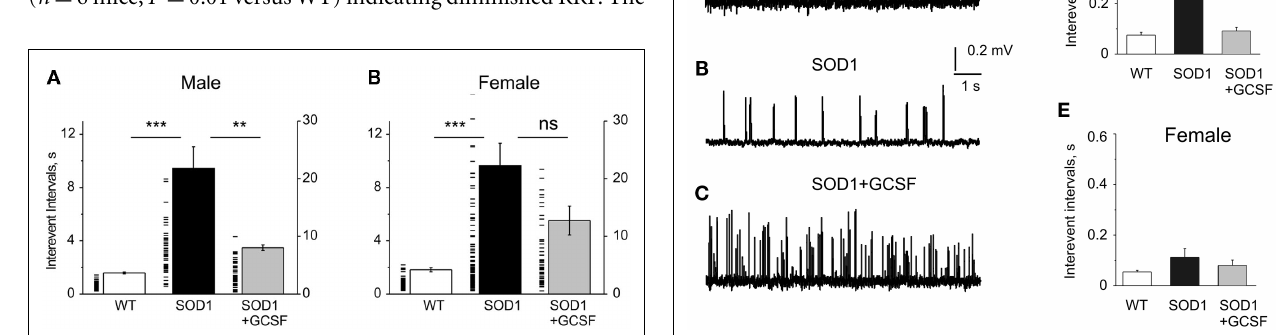
FIGURE 4 | Evaluation of the readily releasable transmitter pool in the sucrose test. (A–C) Examples of sucrose-evoked quantal events inWT, G93A-SOD1, and GCSF-treated G93A-SOD1 male mice, respectively. (D,E) Histograms of mean interevent intervals inWT, G93A-SOD1, and GCSF-treated G93A-SOD1 male (D) and female (E) mice. Note the reduced RRP in G93A-SOD1 male mice and improvement of this parameter in GCSF-treated animals. * = P < 0.05, ** = P <